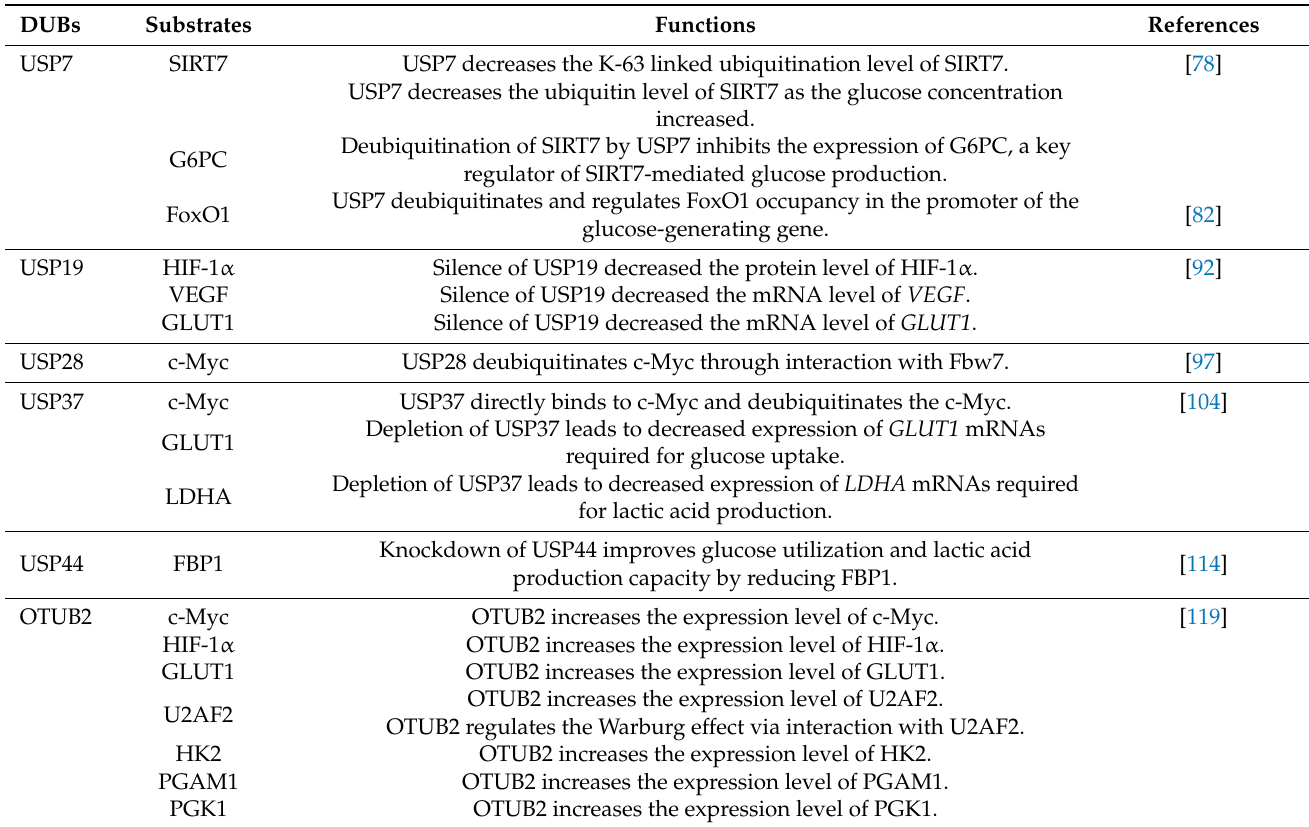
Table 1. The list of DUBs and cellular substrates involved in the Warburg